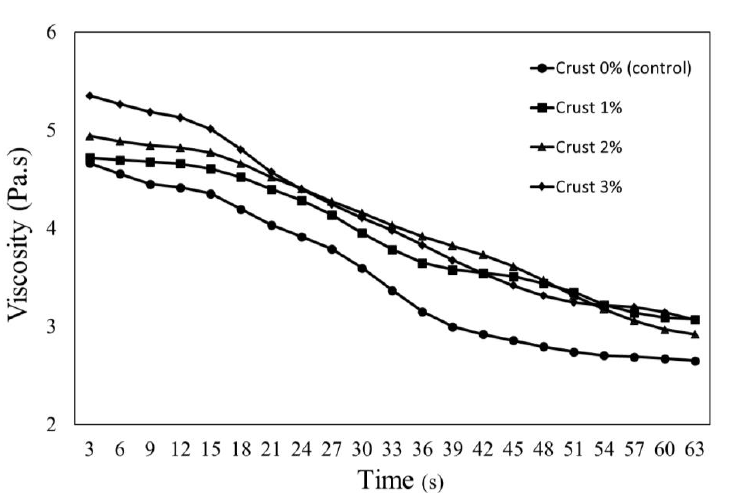
Figure 2. Apparent viscosity of pork patties formulated with various levels of crust derived from dry-aged beef (Hanwoo). The viscosity of uncooked ground meat is affected by physical properties, such as WHC, protein shrinkage, and solubility, and it exhibits a flow curve characteristic of a non-Newtonian fluid [36]. The apparent viscosity of emulsified patties also decreased with increasing rotation time, and this behavior is characteristic of thixotropic fluids; pro- tein molecules (e.g., in ground meat) form a more ordered arrangement with increasing rotation time, leading to a gradual decrease in viscosity [37]. 3.5. Effect of Lyophilized Crust Derived from Dry-Aged Beef ( Hanwoo ) Supplementation on Diameter and Thickness Reduction Ratios The diameter and thickness reduction ratios of the cooked pork patties with various crust levels are shown in Figure 3. The diameter and thickness reduction ratios were sig- nificantly lower in pork patties containing 2% and 3% crust than in the control samples ( p < 0.05). Figure 3. Diameter and thickness reduction ratios of pork patties formulated with various levels of crust derived from dry-aged beef (Hanwoo). a,b,A – C Represent statistically significant differences comparing the same color bar graphs ( p < 0.05).